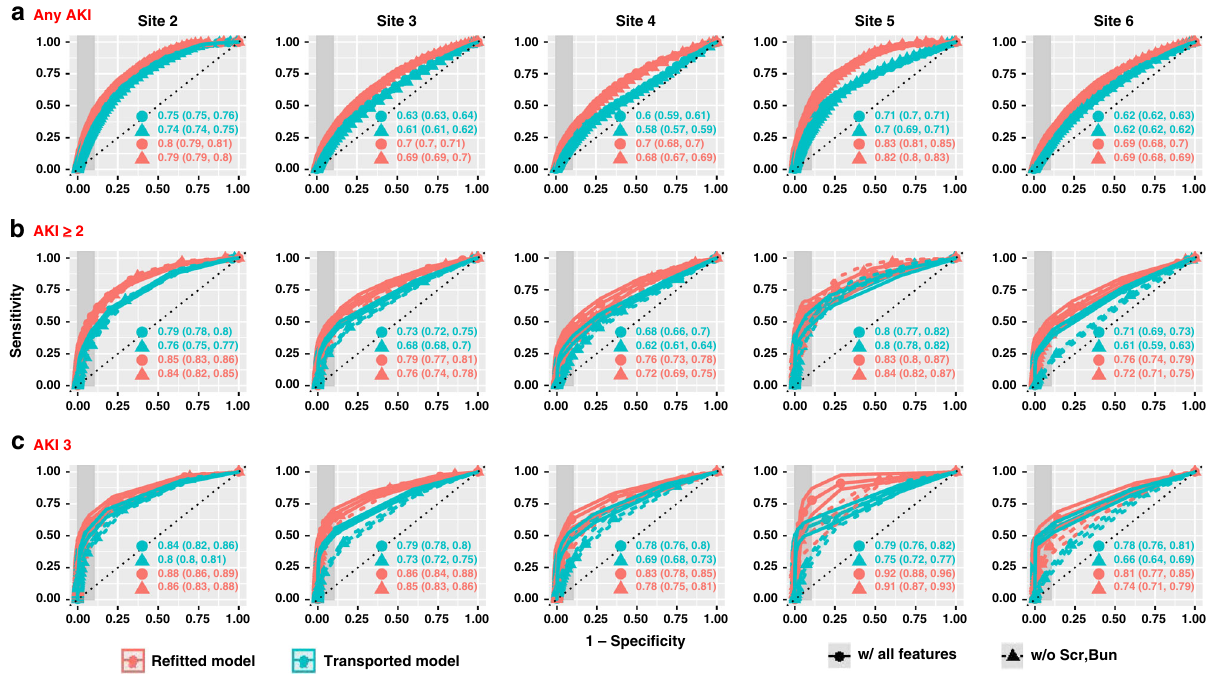
Fig. 3 External validation of the AKI prediction model. a – c Comparison of model performance illustrated by receiver operating characteristic curves for transported model vs re fi tted model in 48-h AKI predictions on external validation site the external sites. Figure 4 shows how common vs speci fi c fea- tures were in relation to their importance rankings in the pre- dictive models, with the y -axis being the percentage of sites that selected certain features (i.e., 1.0 = the most common feature selected by all re fi tted models, 0.17 (1/6) = the most speci fi c feature deemed important by only one site) and x -axis showing the importance feature ranking averaged across sites (i.e., the closer it is to 1, the more important the feature is).